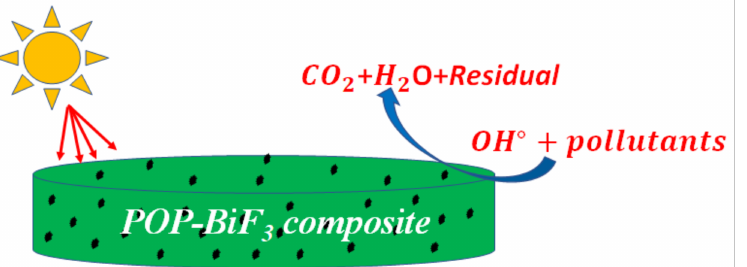
Figure 9. The schematic representation of the proposed mechanism for the photocatalytic degradation of pollutants under UVlight irradiation over POP–BiF 3 composite pellet